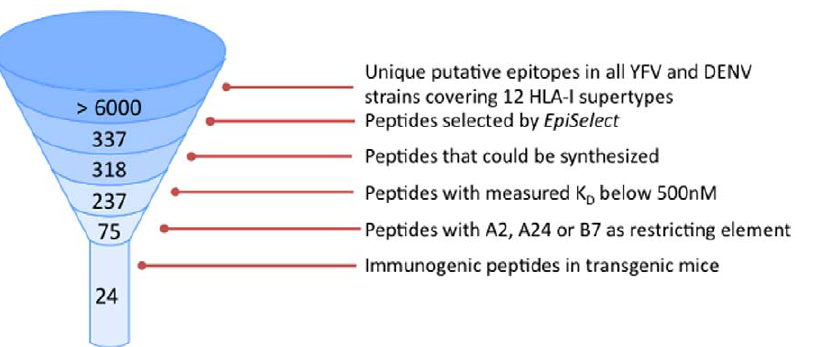
Figure 3. ELISPOT results in 9 mice vaccinated with A*24:03 dengue peptide pool in A*24:02 mice. Peptides positive at concentration 0.1 m g/mL and greater are shown. Results are depicted as percentage of spot-forming cells/million cells of each peptide at 10 m